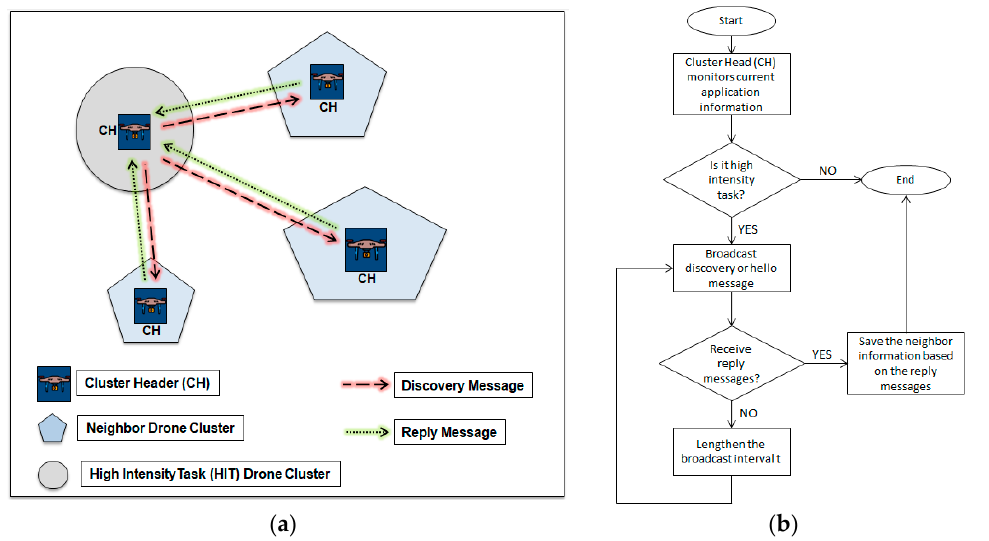
Figure 3. ( a ) Cluster discovery scenario and ( b ) Flowchart of cluster discovery process.